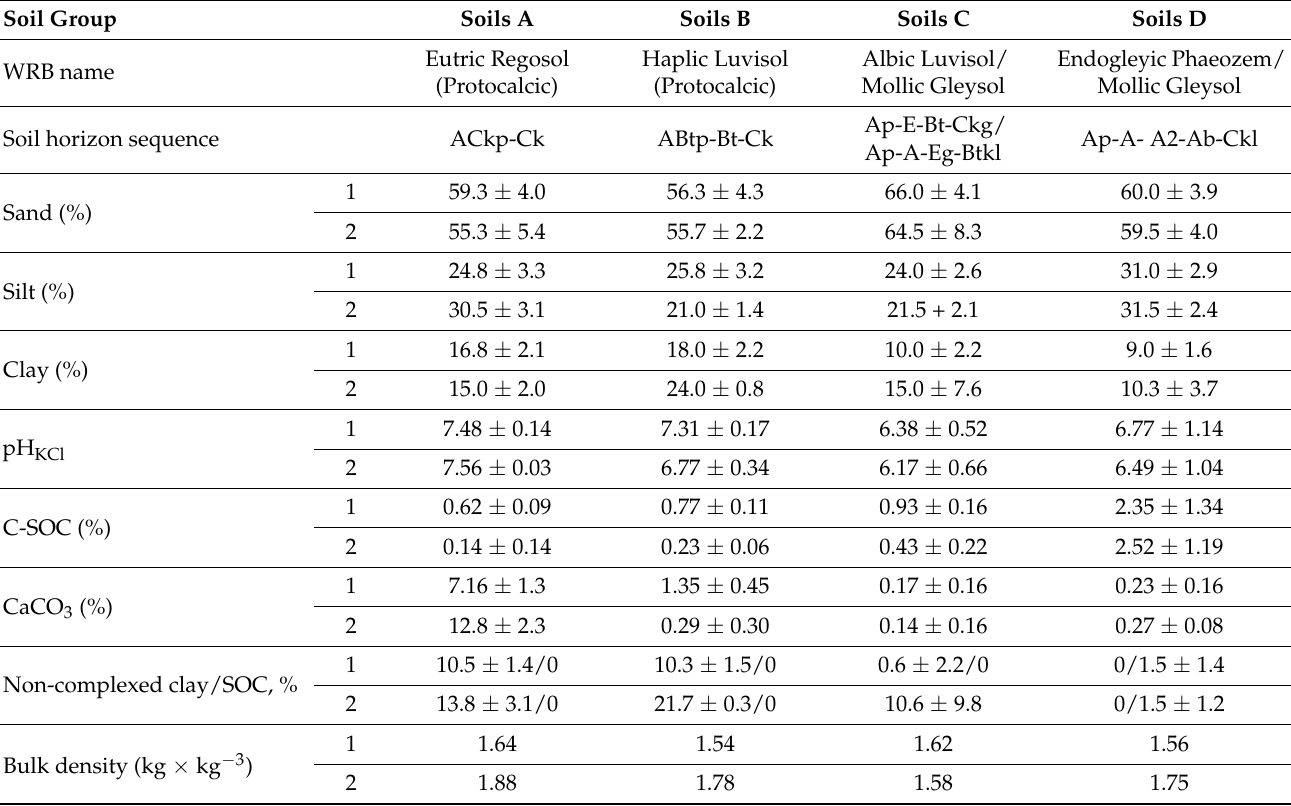
Table 1. Basic properties of the soils under